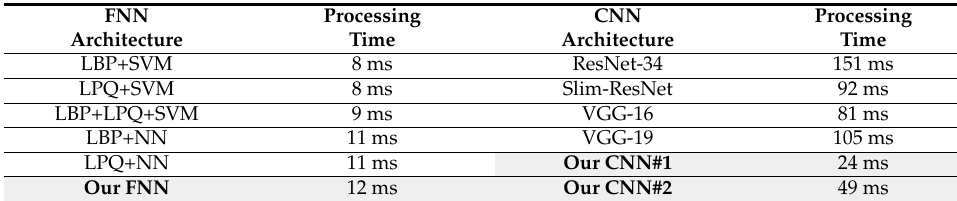
Table 5. The performance comparison of different architectures: processing time.